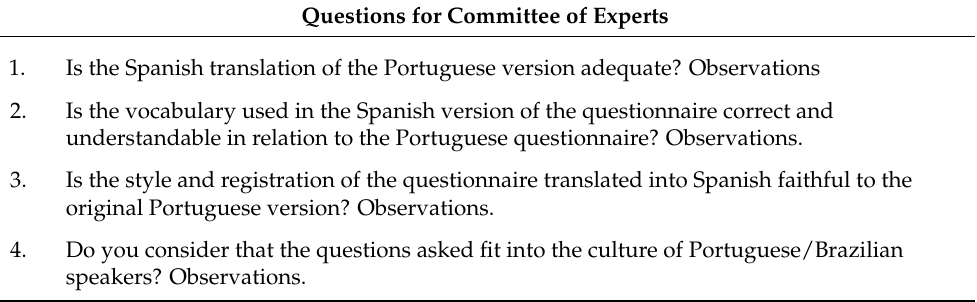
Table 2. Assessment instrument questions for